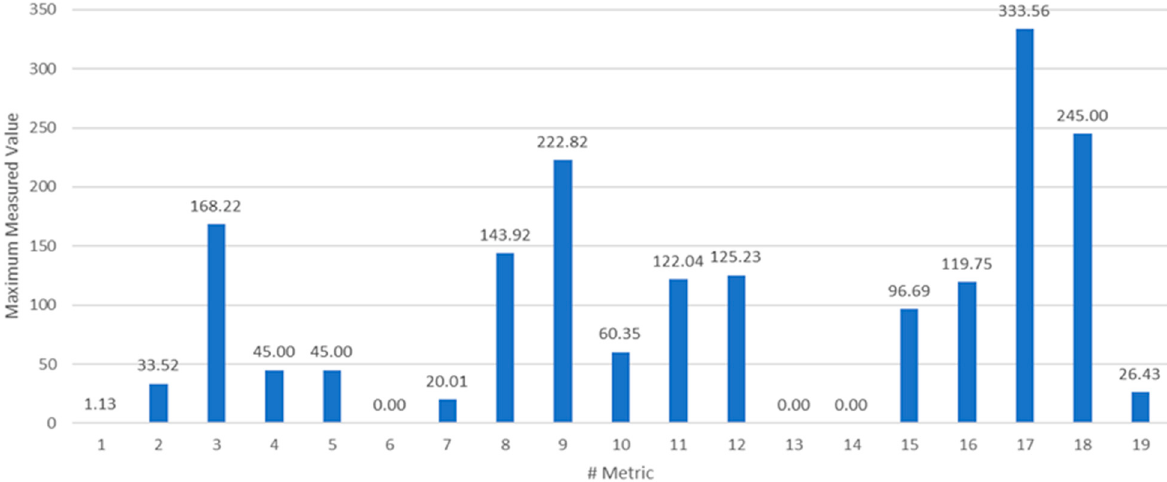
Figure 14. The maximum measured values for each of the metrics.